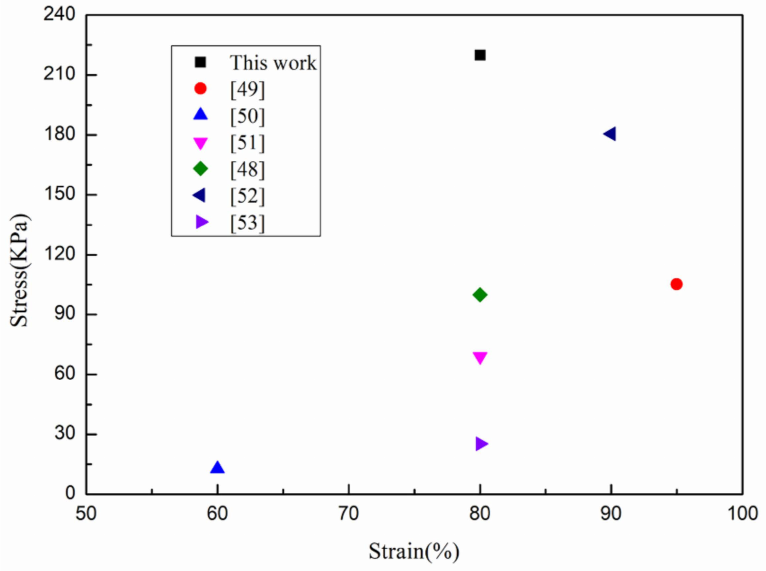
Figure 7. Comparison of the compressive strength of di ff erent materials